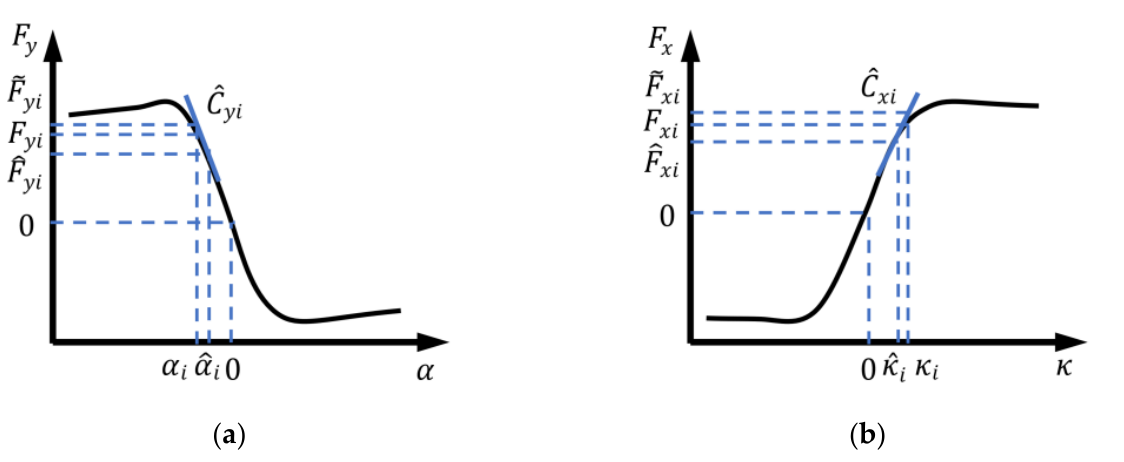
Figure 4. The UniTire tire model with an affine approximation: ( a ) the longitudinal tire force at ˆ α i ;